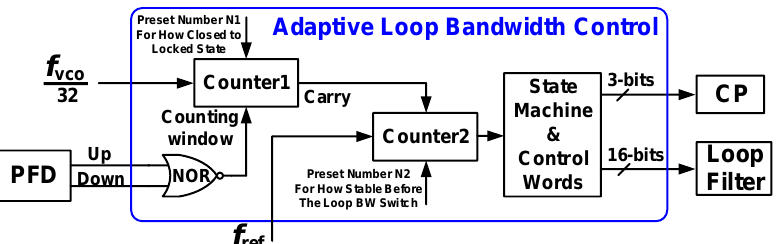
Figure 2. Block diagram of the adaptive loop bandwidth control (adaptive loop bandwidth control (ALBC))